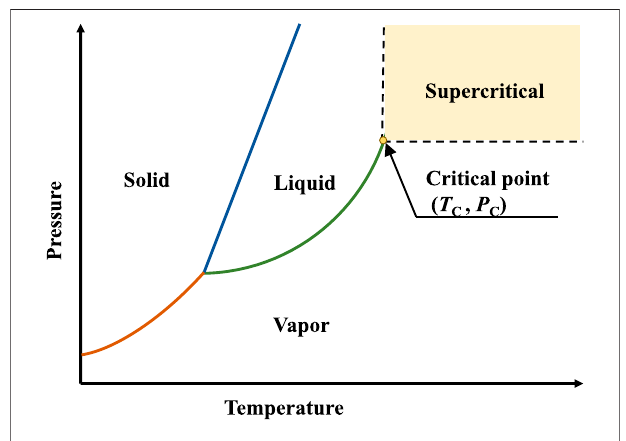
FIGURE 1 | Phase diagram (pressure – temperature) of substance (Debenedetti et al., 1994).